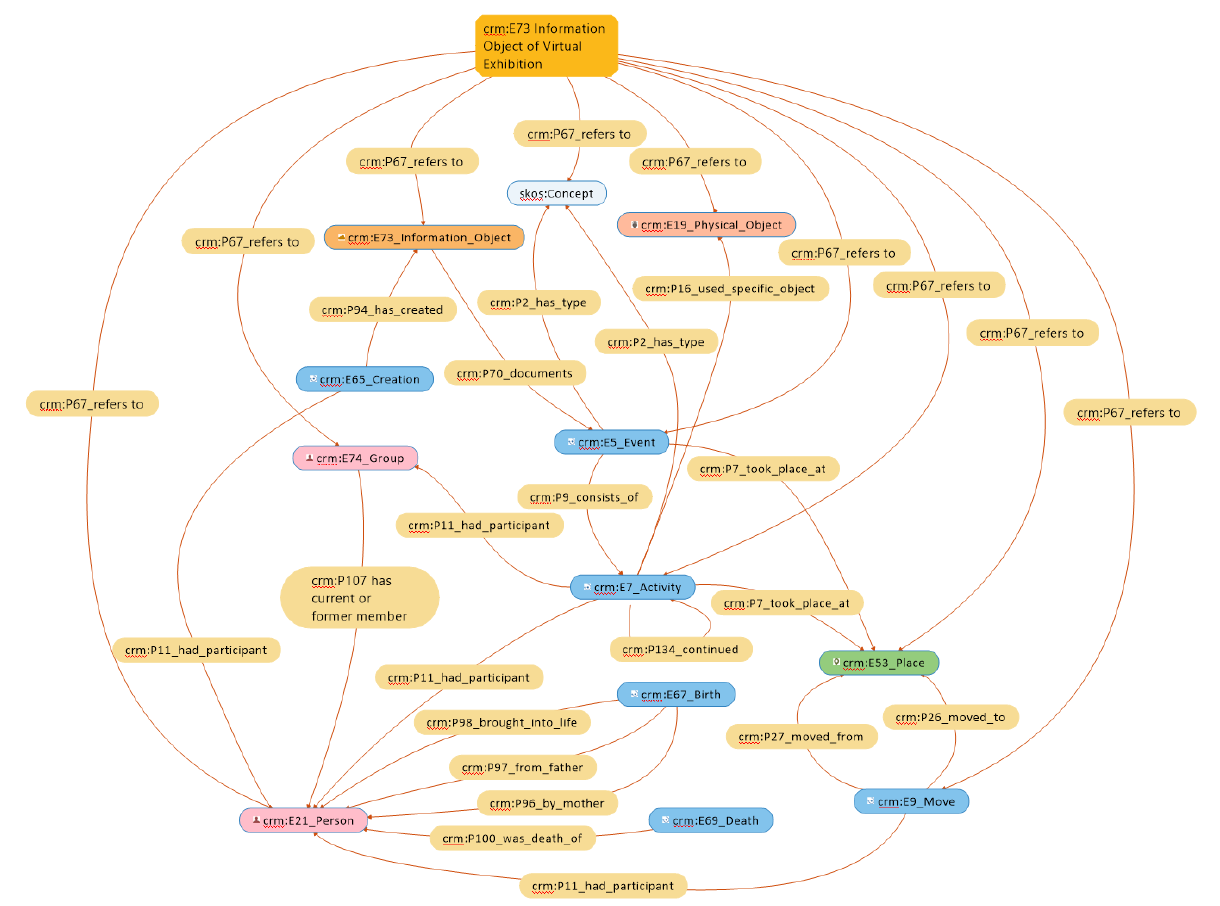
Figure 4. The modelling of the virtual exhibition